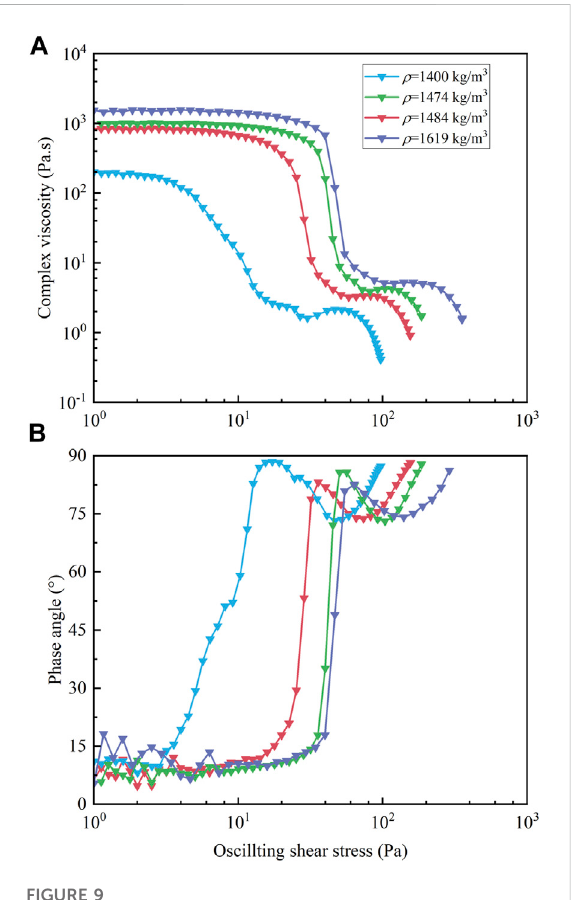
FIGURE 8 Results of oscillatory stress sweep tests for different mud samples: (A) the storage modulus G ′ and (B) the loss modulus G ″ .